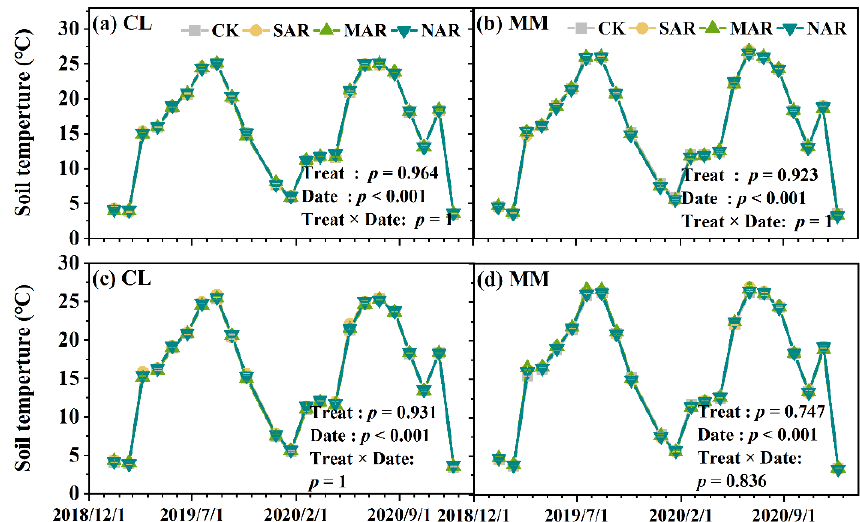
Figure 1. Seasonal variations in soil temperature in untrenched plots ( a , b ) and trenched plots ( c , d ) under different types of acid rain in Cunninghamia lanceolata (Lamb.) Hook. (CL, a , c ) and Michelia macclurei Dandy (MM, b , d ) plantations from January 2019 to December 2020. Vertical bars represent standard errors ( n = 4).